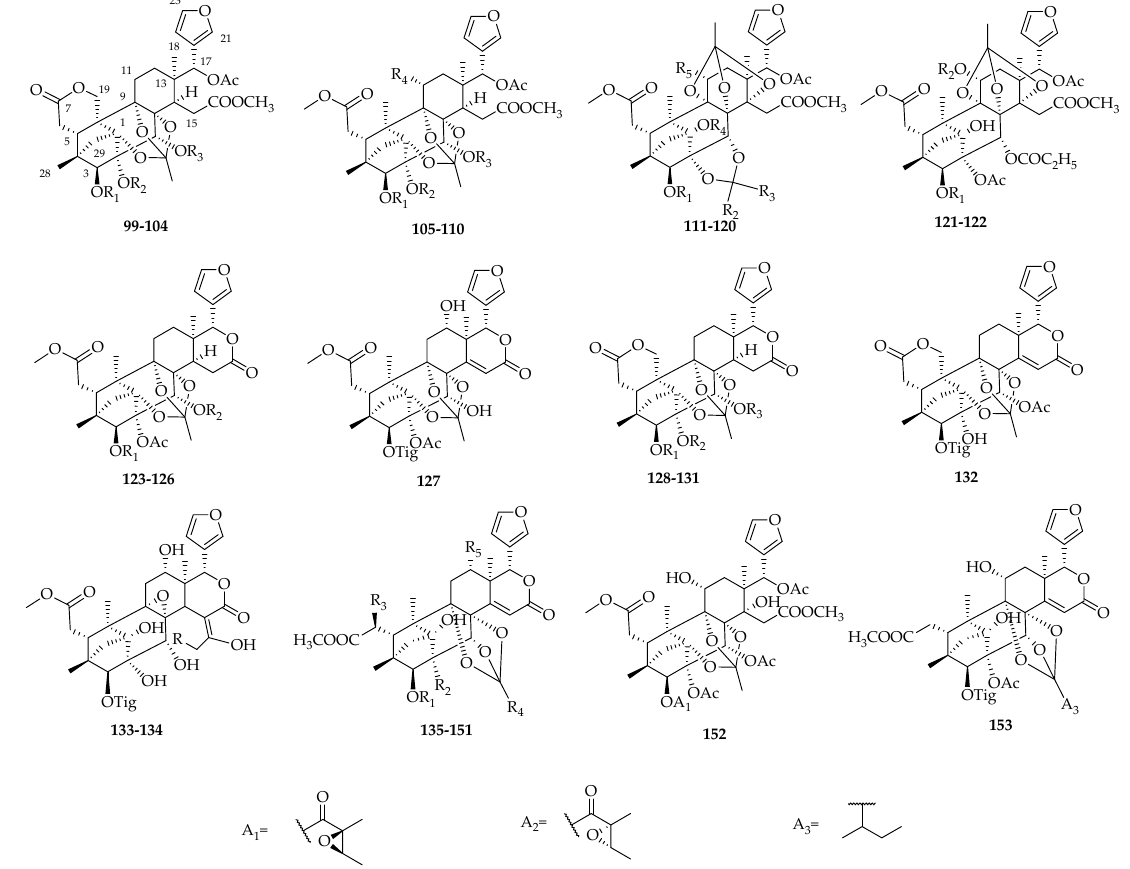
Figure 5. Chemical structures of phragmalin ‐ type limonoids 99 – 153 . Table 4. Structures and sources of phragmalin ‐ type limonoids 99 – 153 .